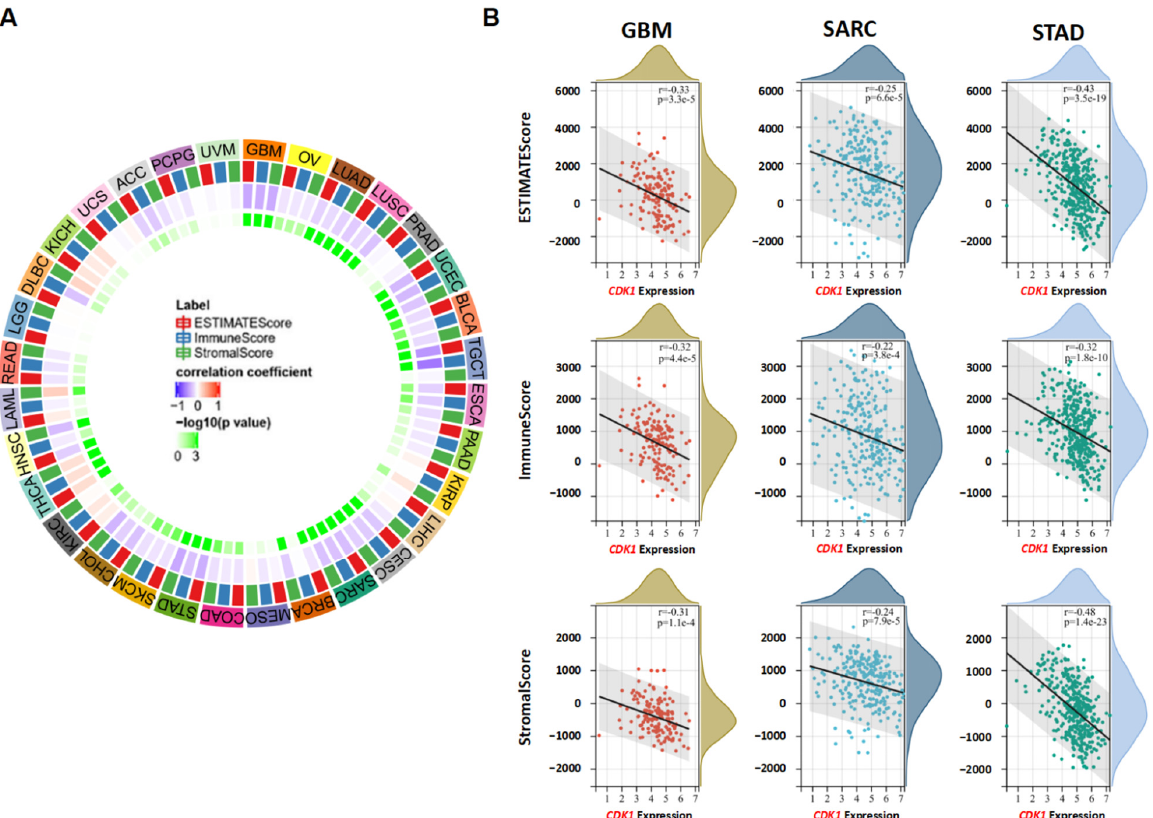
Figure 8. The association of CDK1 expression with ESTIMATEScore, ImmuneScore, and StromalScore in tumors. ( A ) The heatmap shows that CDK1 expression was significantly associated with these scores in some tumors. ( B ) Representative scatter plots of GBM, SARC, and STAD are shown. Pearson’s correlation coefficients.